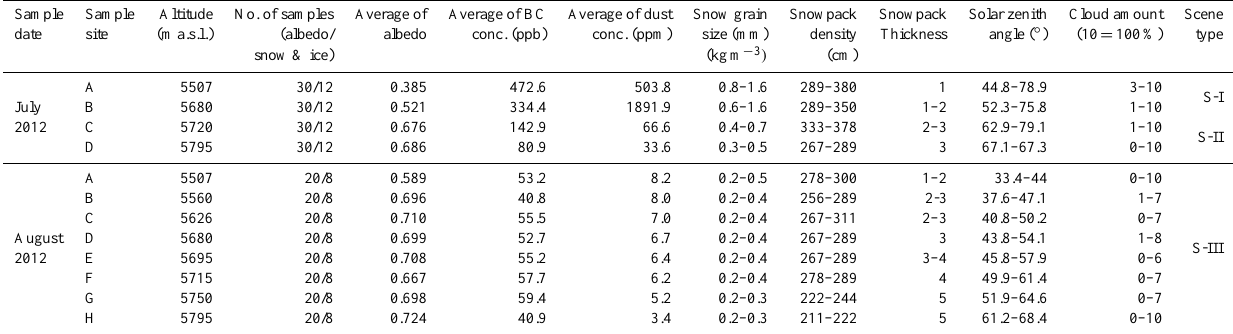
Figure 1. Location of the Zhadang glacier on Mt Nyainqentanglha. Table 1. Sampling information: two expeditions were conducted on the Zhadang glacier, and samples (albedo, snow/ice) were collected under three melting conditions of the glacier in July and August of 2012. We measured the albedo five to six times at each site whilst collecting two to three snow/ice samples. In total, 120 albedo measurements and 48 snow/ice samples were obtained at the A–D sample sites in July 2012 for the S-I and S-II conditions (Fig. 2). A total of 160 albedo samples and 64 snow samples were obtained at all sampling sites in August 2012. The albedo and concentrations of BC and dust are listed